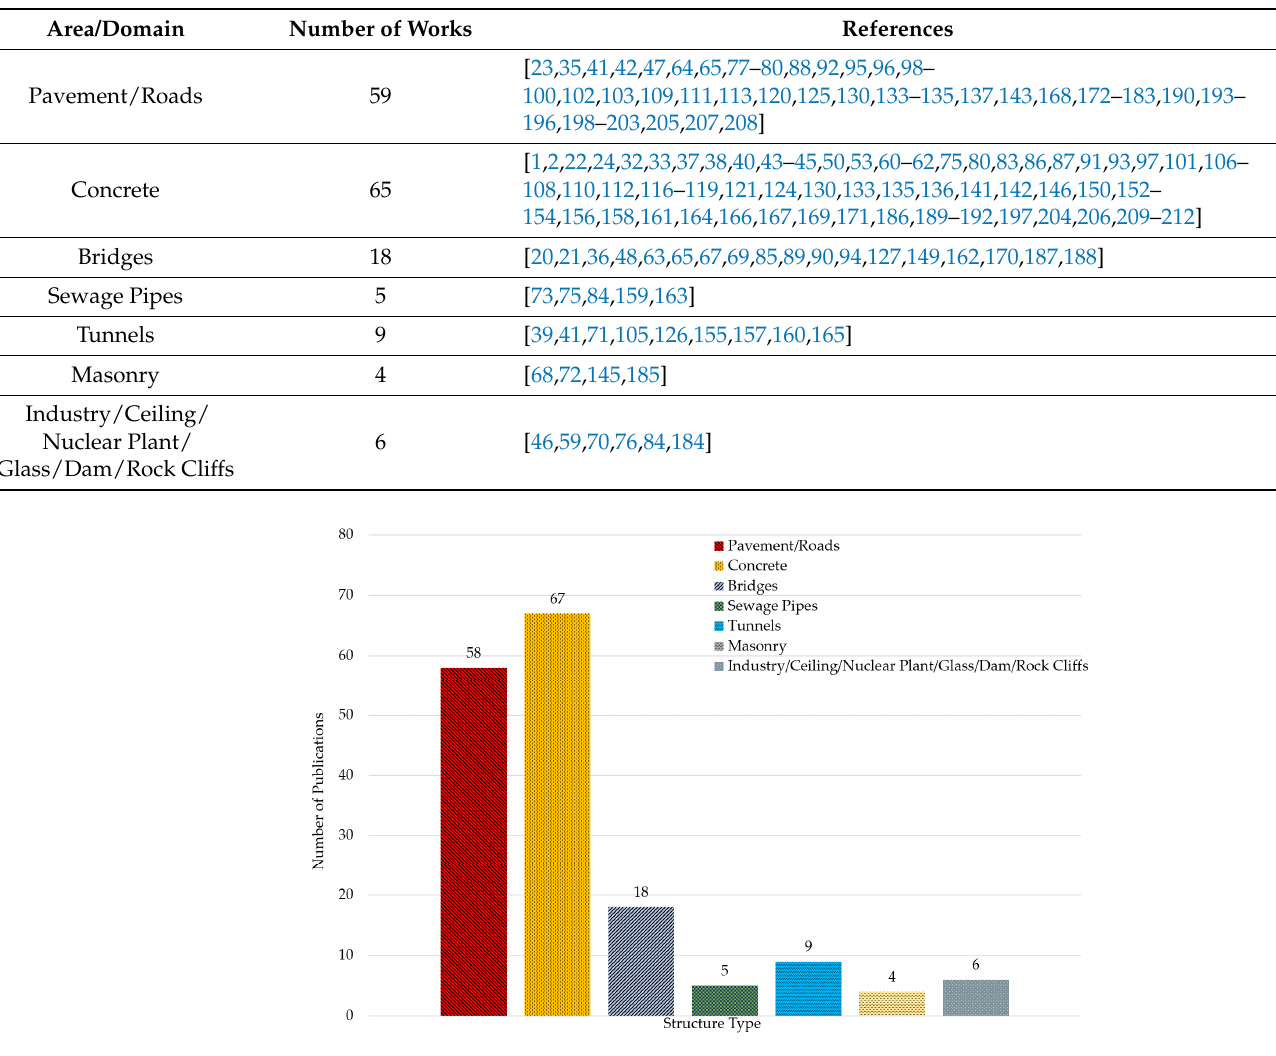
Figure 10. Distribution of retrieved articles based on domain.